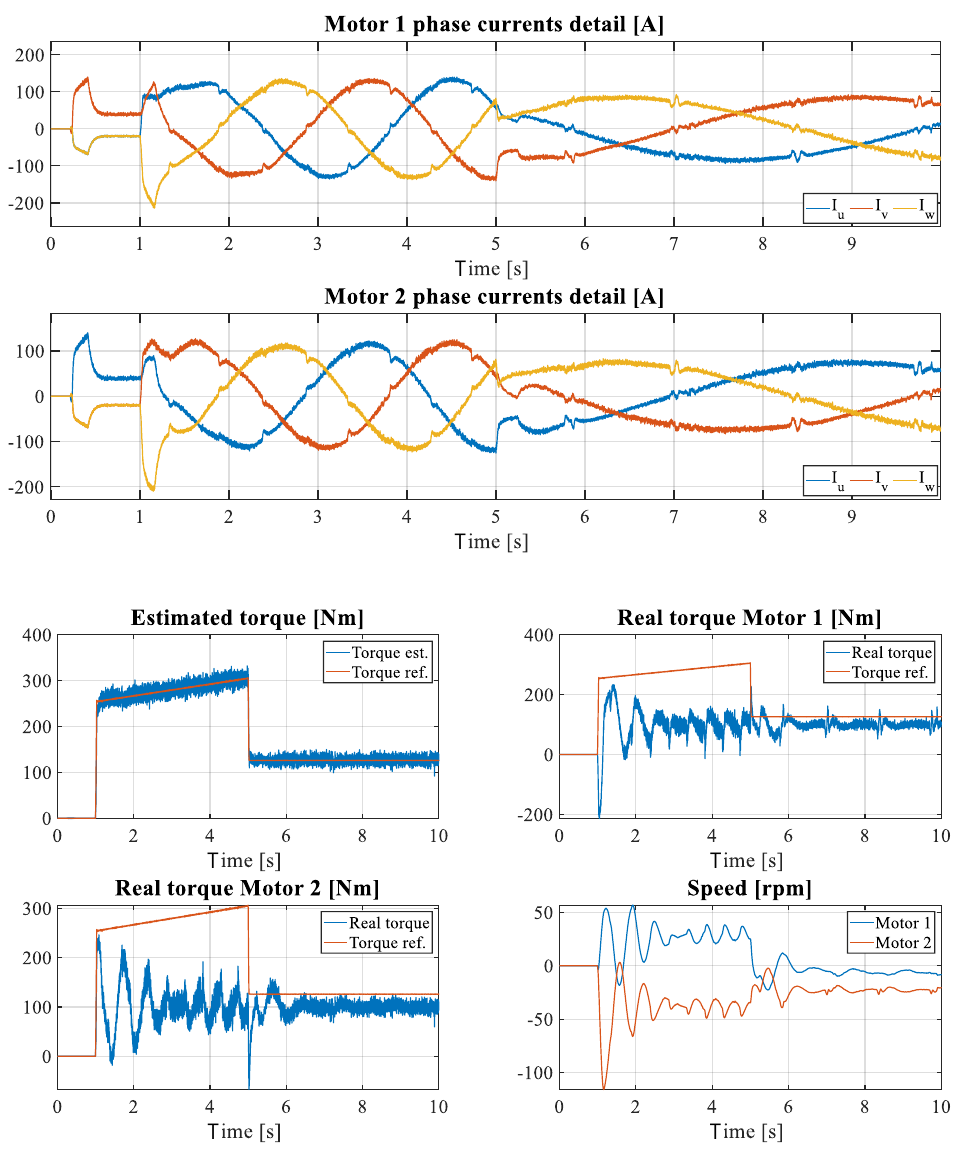
Figure 8. Phase currents of motor 1 and motor 2 at 2400 rpm and 100 Nm load (opposite-phase wiring fault at t = 0